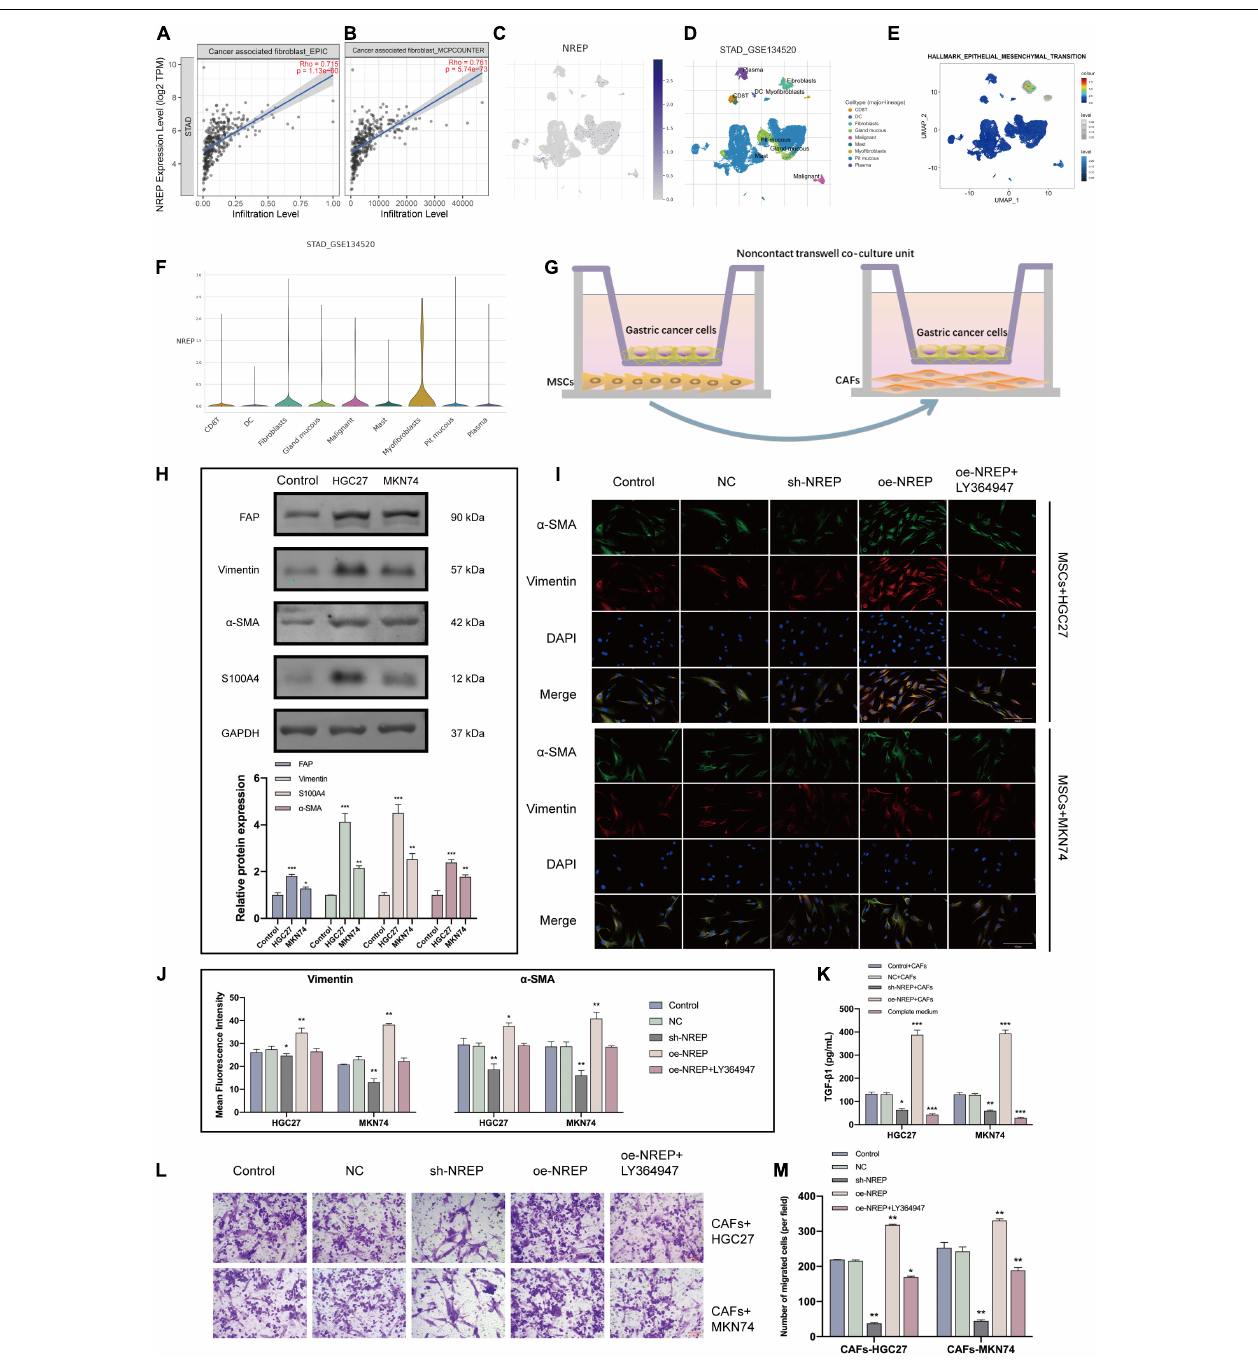
FIGURE 6 | NREP upregulation in gastric cancer (GC) promotes the activation and recruitment of cancer-associated fibroblasts (CAFs). (A,B) Correlation of NREP expression with CAFs based on the Fei et al., 2018 (A) and Li et al, 2020 (B) datasets. (C) Uniform manifold approximation and projection (UMAP) plots illustrating the expression of NREP clusters. (D) UMAP plots illustrating the GC cell landscape. We found nine cell clusters across 56,440 cells after quality control, dimensionality reduction, and clustering. (E) Enrichment score for genes from the Hallmark hypoxia gene set in each cell, obtained using gene set variation analysis. (F) Violin plots for GC cell cluster marker genes and NREP in different cell types. Expression was measured as log 2 (TP10K + 1). (G) A non-contact co-culture unit of MSCs and GC cells established by incubating MSCs with GC cells at a 1:1 ratio. (H) After co-culture with GC cells for 4 days, CAF-related markers were examined using western blots. (I) Immunofluorescence staining of MSCs co-cultured with GC cells (control cells and GC cells transfected with the NC, sh-NREP, and oe-NREP constructs) treated with 5 µ M LY364947 (magnification, × 400). (K) After co-culture with different groups of GC cells for 4 days, ELISA assays were used to demonstrate an increase in the TGF- β 1 protein levels in the supernatant of the co-culture system. (L) The transwell system was used to investigate the ability of GC cells to recruit CAFs. (magnification, × 200). (M) The number of migrated cells was counted using Image (J) . (* P < 0.05, ** P < 0.01, and *** P < 0.001).